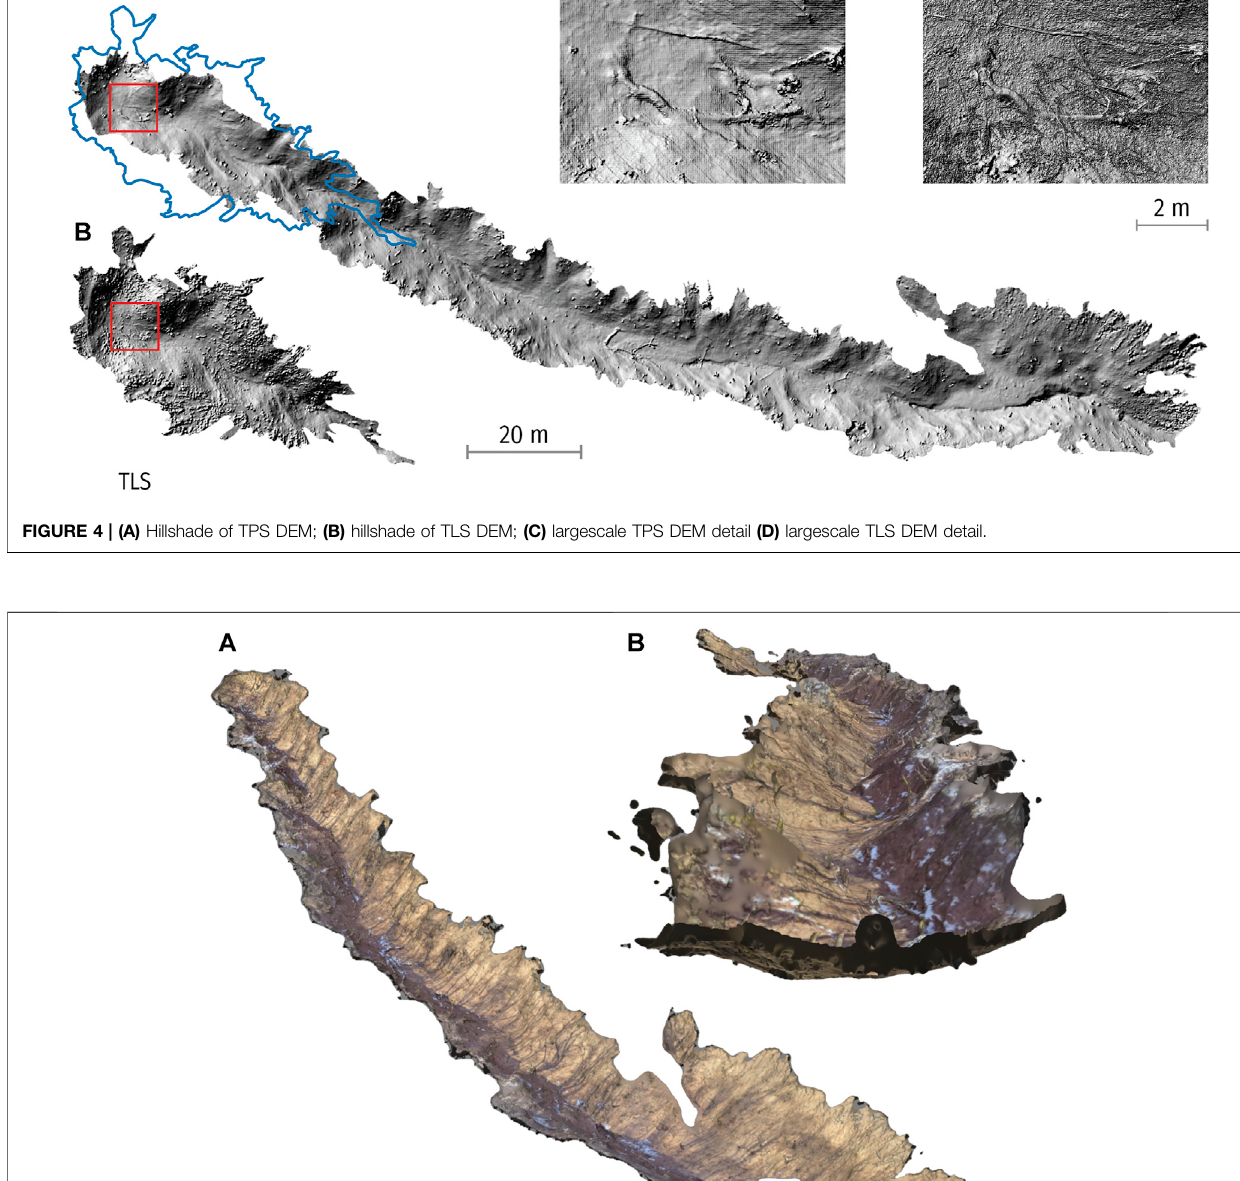
Frontiers in Environmental Science |